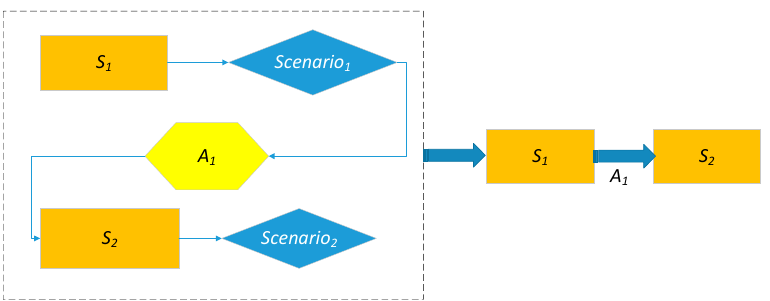
Figure 3. Correspondence between scenario analysis and rules.